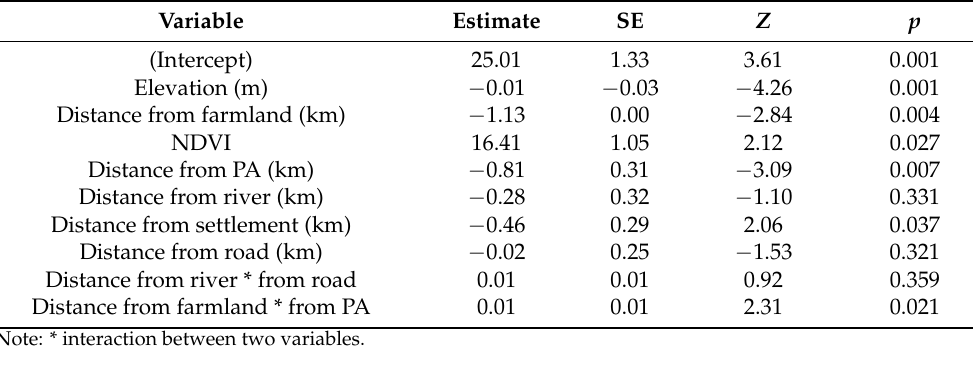
Table 3. Binary multiple logistic regression analysis results of variables influencing human-elephant conflict occurrences ( n = 923), collected by Oikos East Africa, household interviews ( n = 96), collared elephant home ranges ( n = 3) and grey literature reports in the Enduimet Wildlife Management Area, Tanzania, from 2016 to 2020. PA = protected area, NDVI = Normalized Difference Vegetation Index.